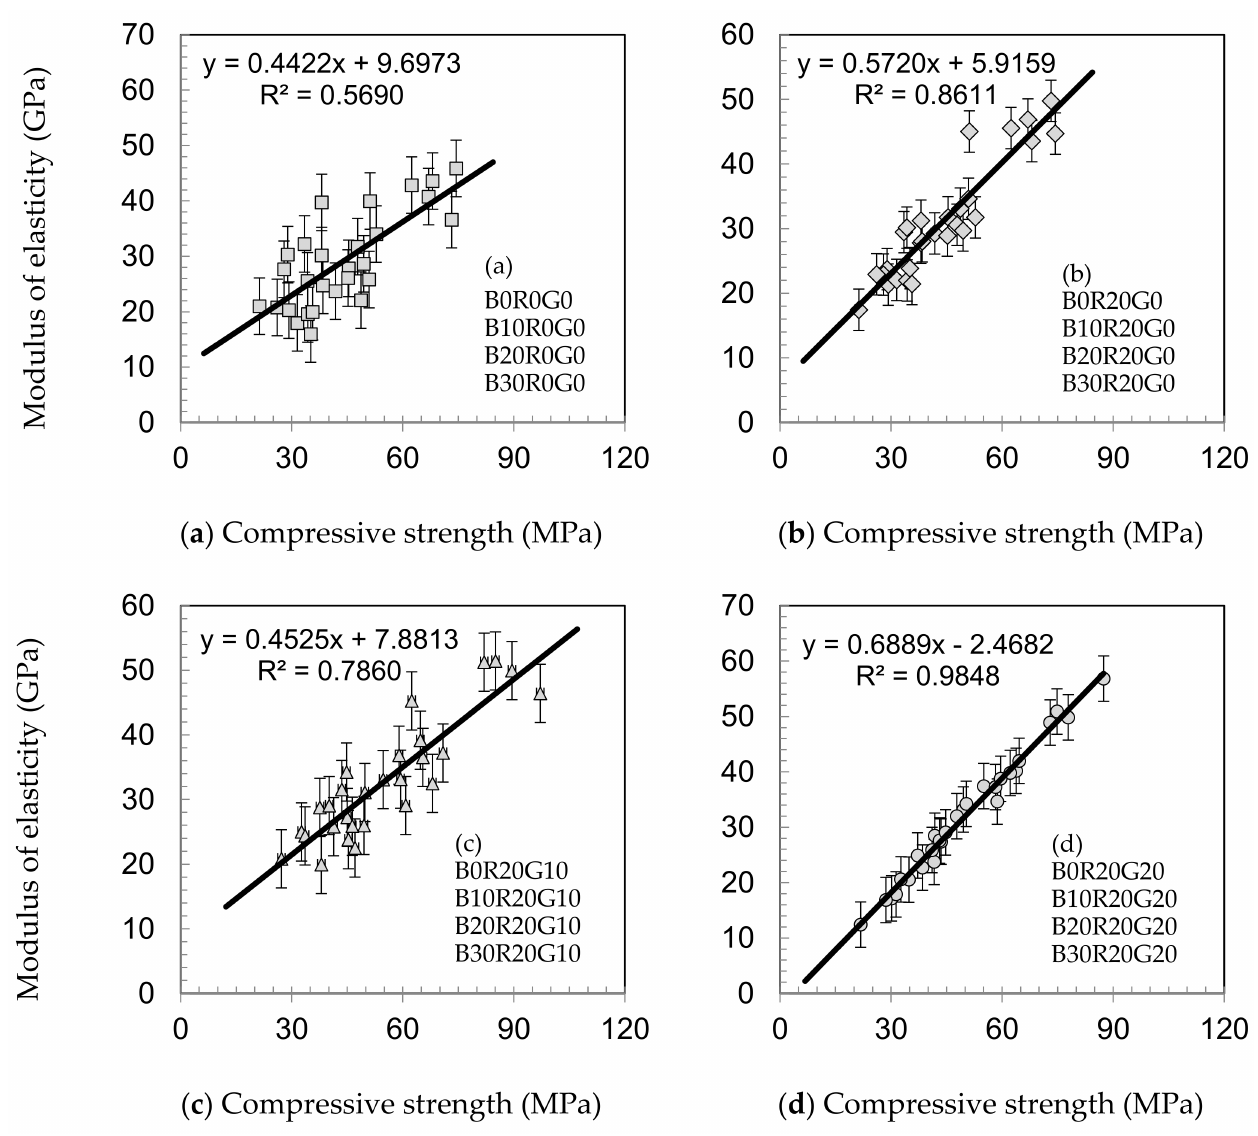
Figure 7. Relationships between the modulus of elasticity and compressive strength of gSCC. ( a ) with BA, ( b ) with BA+20%RHA, ( c ) with BA+20%RHA+10%GCW, and ( d ) with